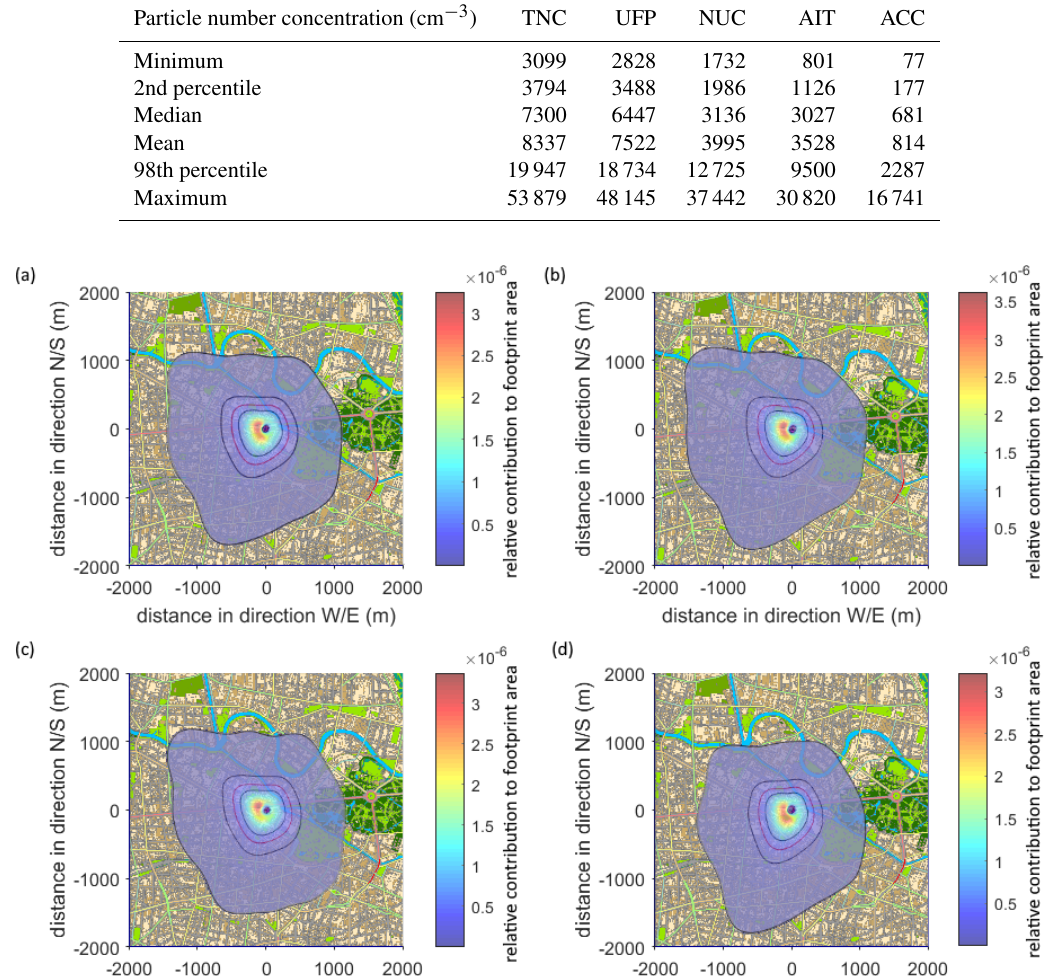
Table 2. Statistical quantities of TNC and UFP as well as particle number concentrations of the modes NUC, AIT, and ACC.